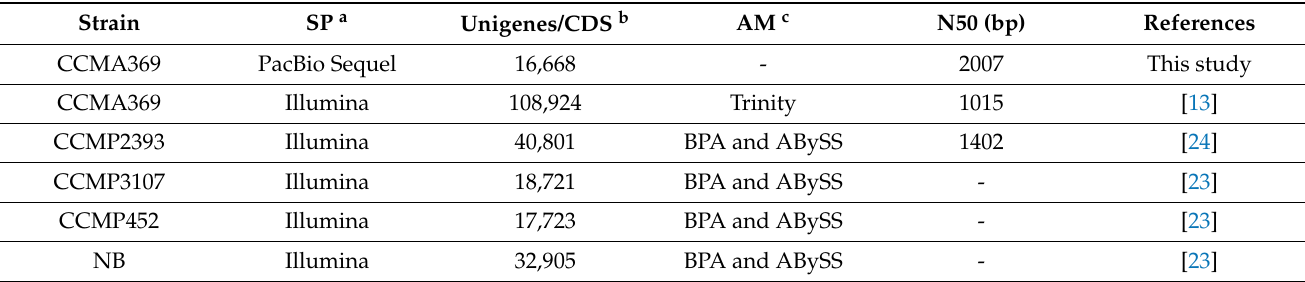
Table 2. Information on the available Heterosigma akashiwo transcriptome.